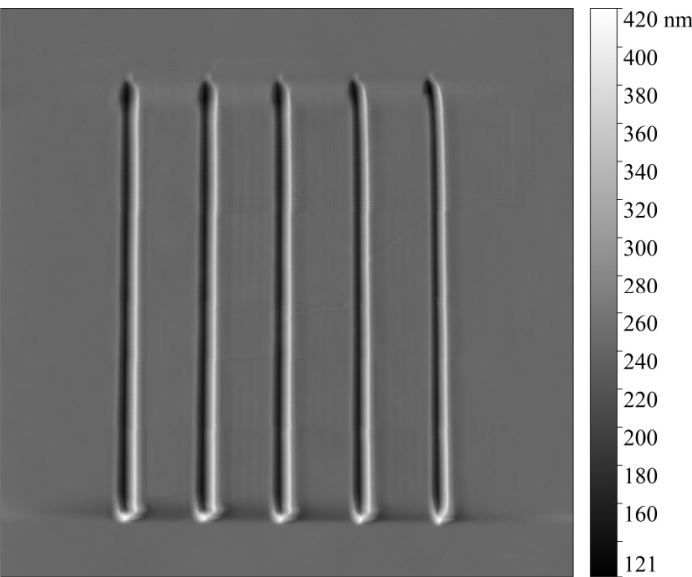
Figure 3. Grooves machined by an unworn AFM probe. Table 1. Nanomachining parameter setting in the